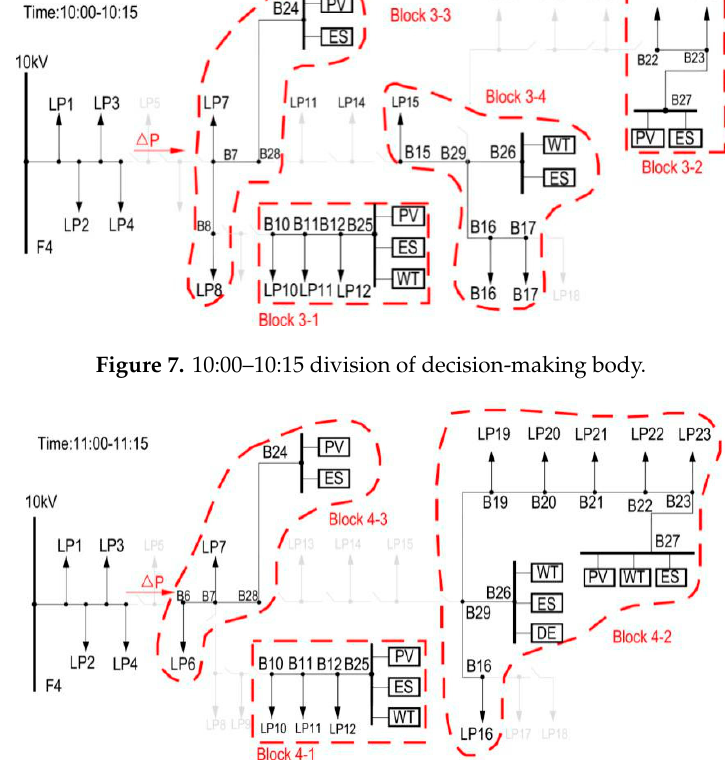
Figure 8. 11:00–11:15 division of decision-making body.